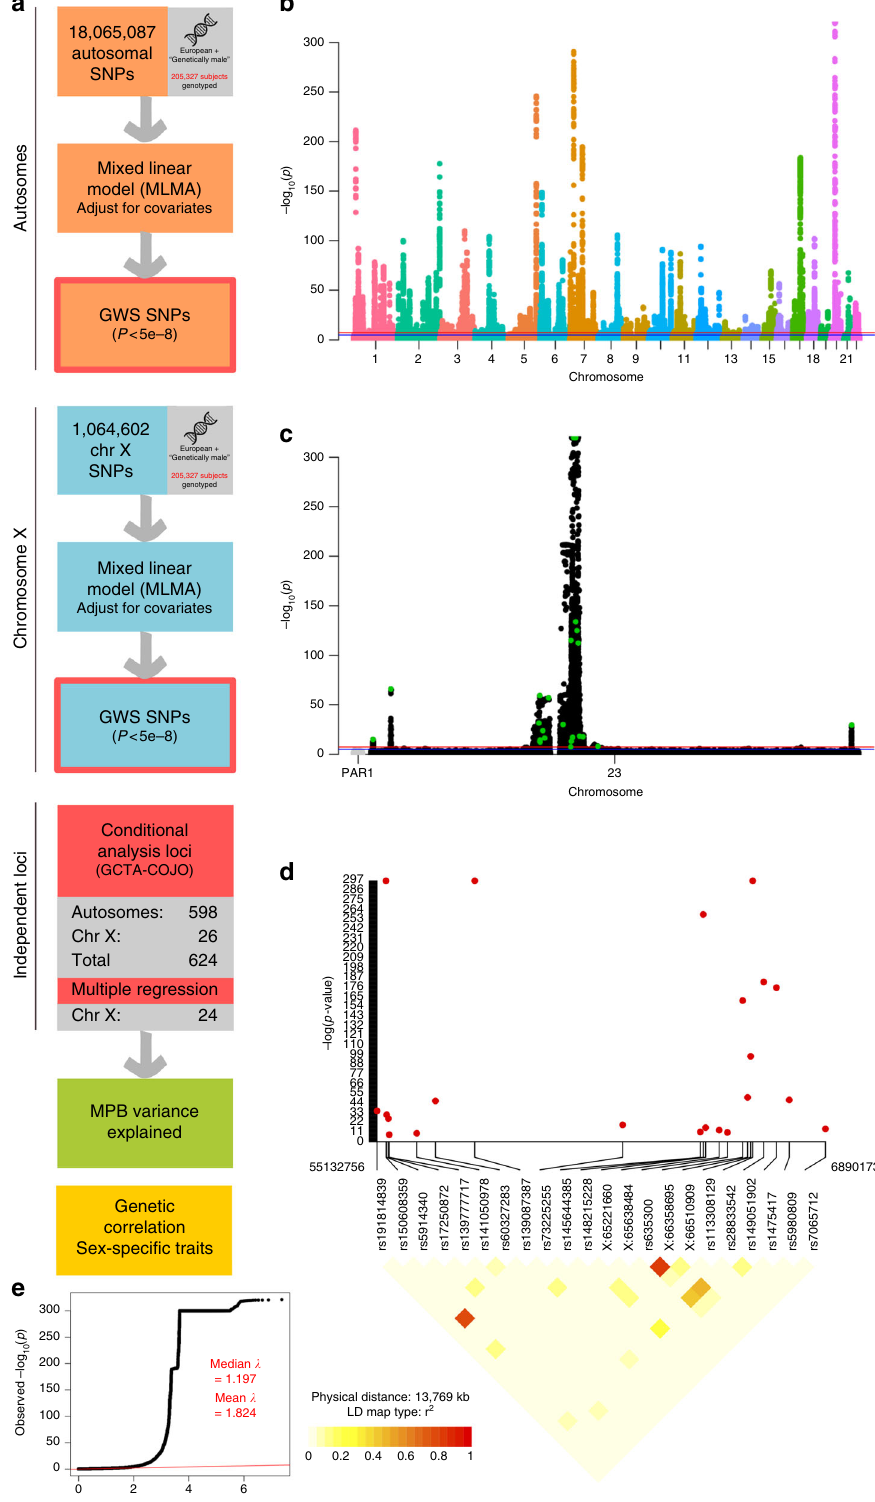
Fig. 3 MPB GWAS. a Work fl ow diagram. b , c Manhattan plots for the autosomal GWAS ( b ) and the XWAS ( c ), depicting p -values from the BOLT-LMM 24 in fi nitesimal mixed-model association test. Green points denote 26 GWS SNPs identi fi ed by the COJO 25 analysis. Chromosome 23 is the X-chromosome and chromosome PAR1 is pseudo-autosomal region 1. d LD plot for the p22.31-q13.2 region, containing jointly signi fi cant X-chromosome SNPs from the COJO 25 analysis. e QQ-plot for the aggregated set of autosomal and X-chromosome GWAS P